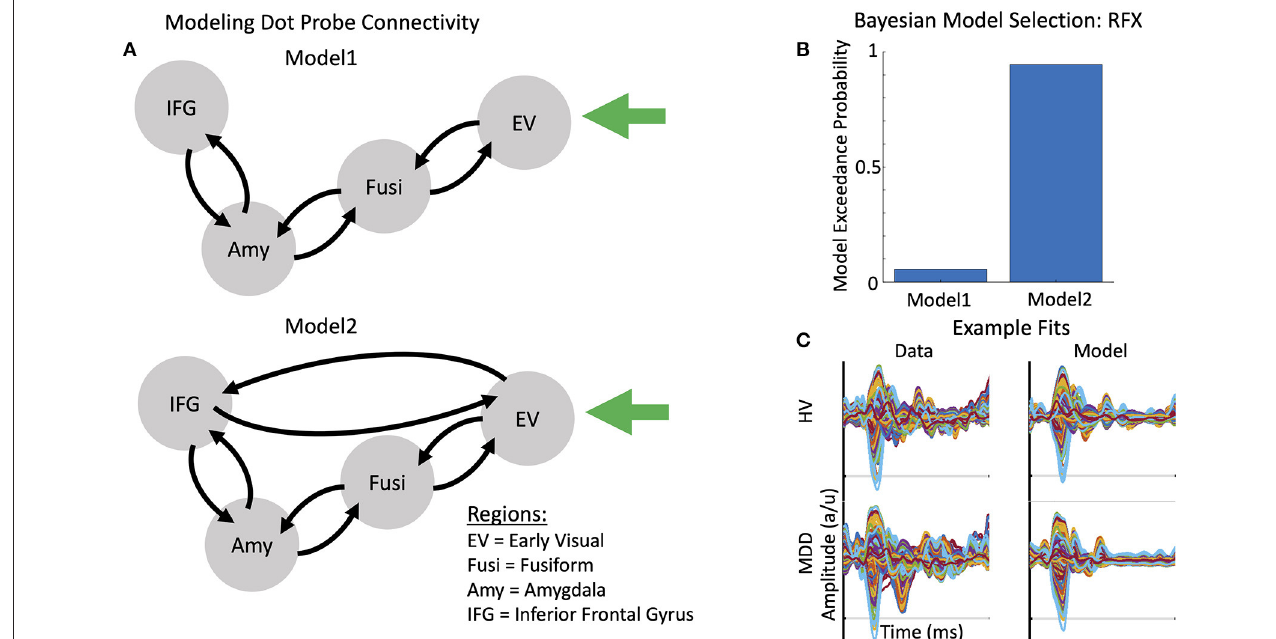
FIGURE 2 | Models of connectivity, winning model, and example model fits. (A) Two plausible models were constructed to account for message passing between the early visual cortex (EV), fusiform cortex (Fusi), amygdala (Amy), and inferior frontal gyrus (IFG). Model 1 included reciprocal forward and backward connections from the EV to the Fusi, from the Fusi to the Amy, and from the Amy to the IFG. Model 2 included a direct, reciprocal, forward and backward connection from the EV to the IFG. (B) Bayesian Model Selection (BMS) was used to adjudicate between models, demonstrating that Model 2, with fully interconnected feedforward and feedback connections between each region, had the greatest exceedance probability. RFX, random effects. (C) Example evoked responses (left) and model fits (right) for a healthy volunteer (HV, top) and participant with treatment-resistant major depressive disorder (MDD)